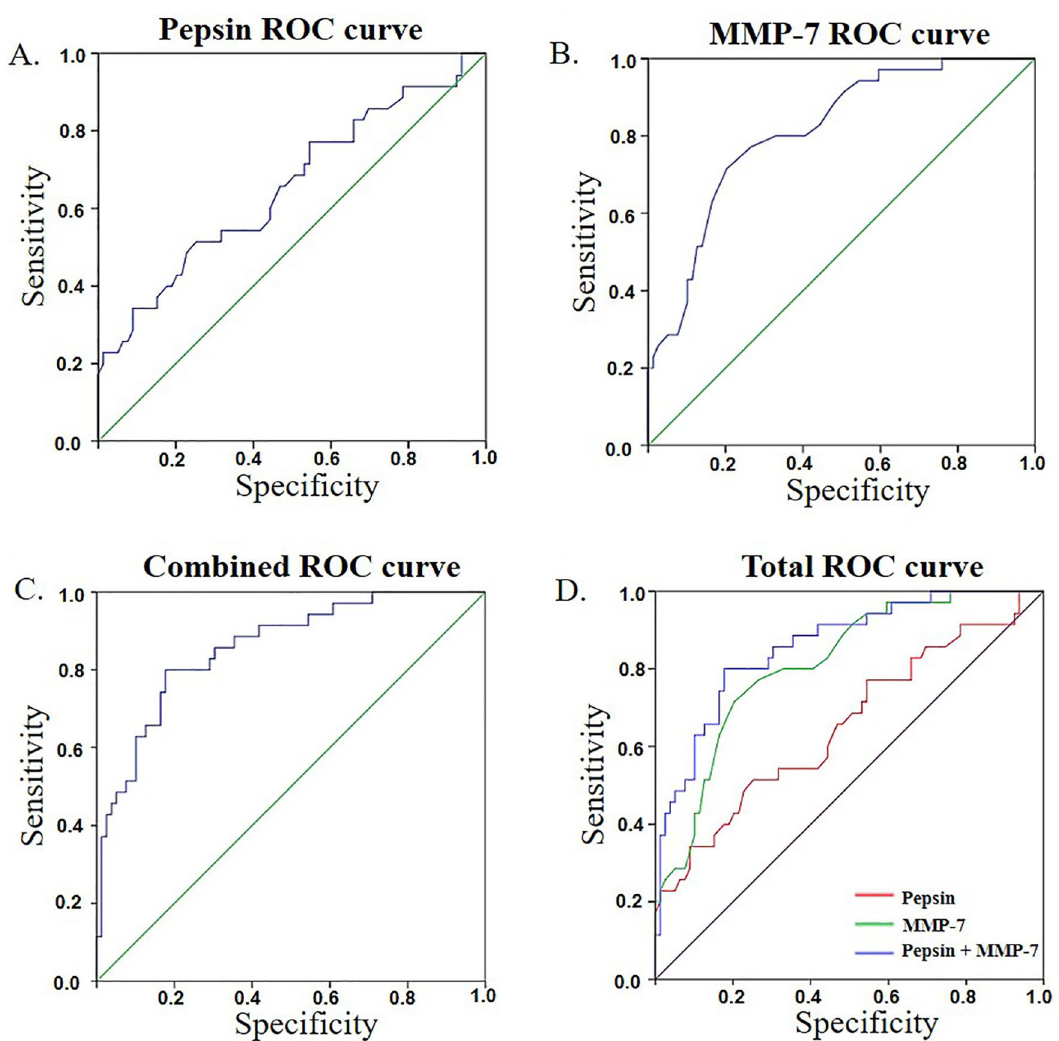
Figure 3. Receiver operating characteristics curve analysis for finding an optimal cut-off value of salivary pepsin and MMP 7 concentration needed to identify LPRD patients. ( A ) ROC curves generated with pepsin (blue line), base (green line) ( B ) ROC curves generated with MMP-7 (blue line), base (green line) ( C ) ROC curves generated with combined pepsin and MMP-7 (blue line), base (green line) ( D ) ROC curve total combining ( A ) (yellow line), ( B ) (green line) and ( C ) (blue line) and base (purple